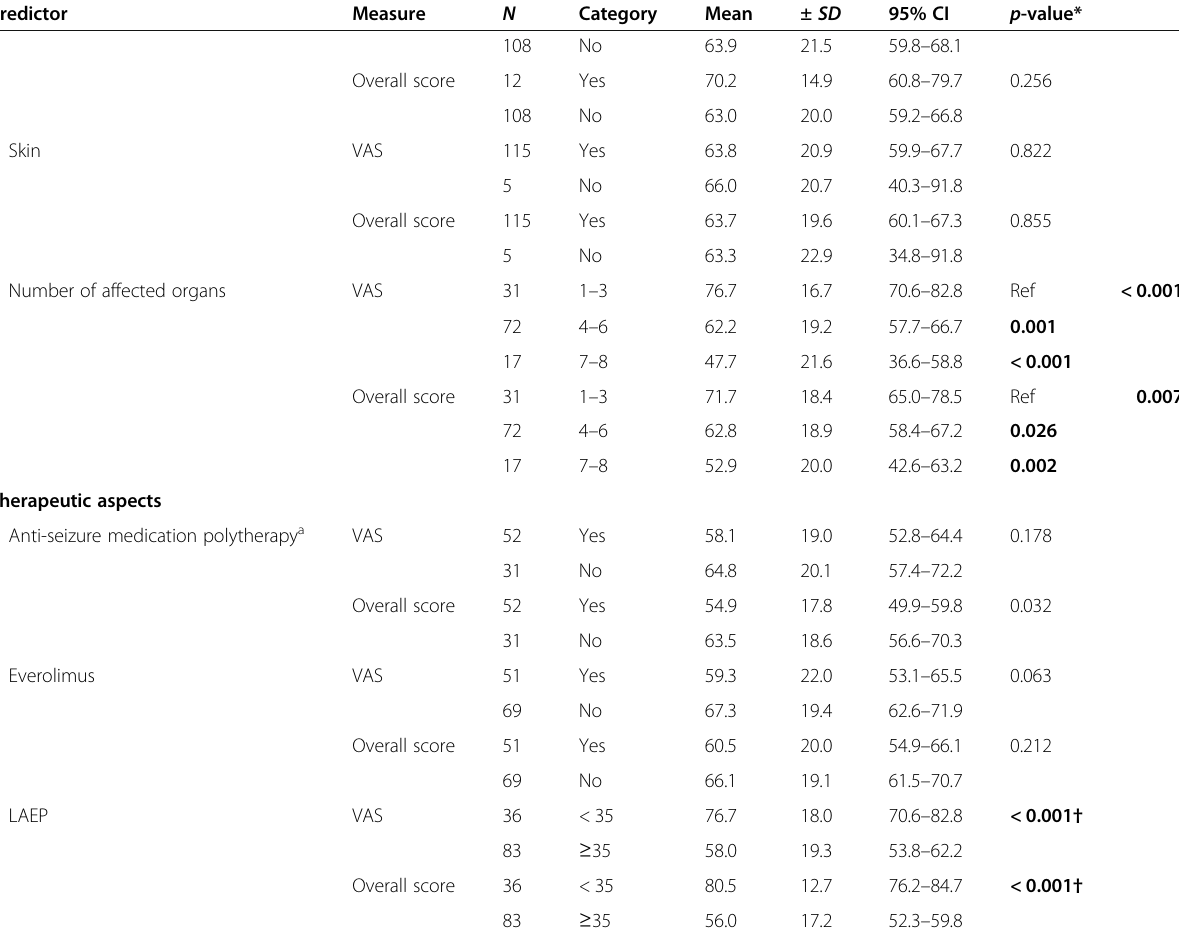
Table 3 Comparisons of health-related quality of life among individuals with TSC, as measured by the QOLIE-31 (German version) questionnaire, according to several potential predictors and assessed using the Kruskal – Wallis and Chi-square tests (Continued)